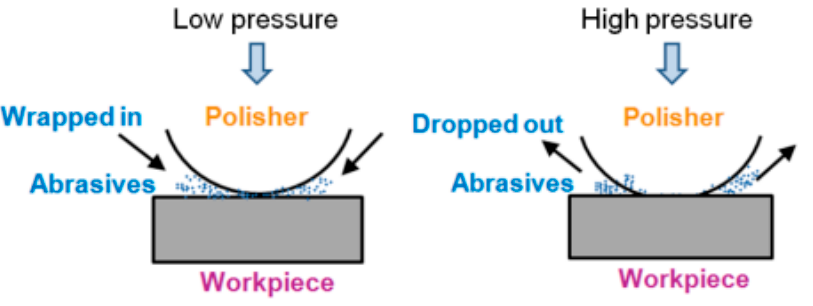
Figure 10. A general model of the material removal mechanism in vibration-assisted polishing.